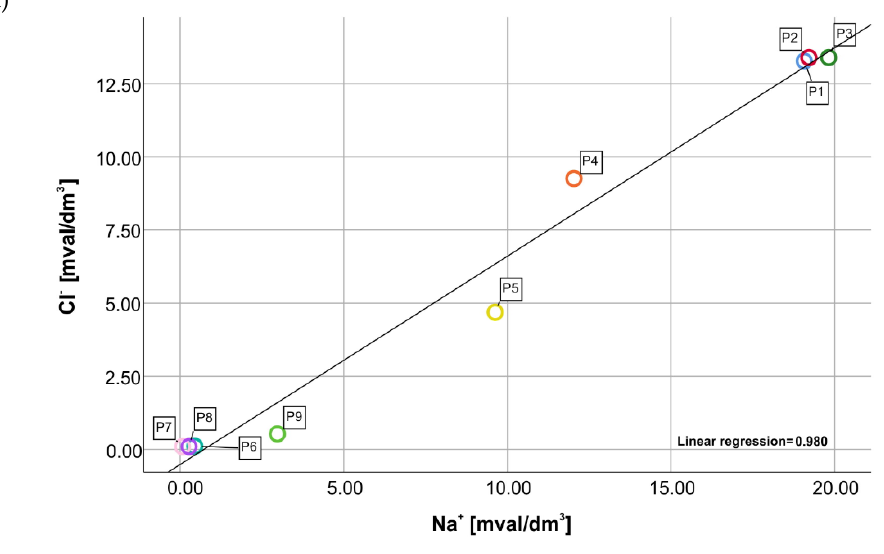
Table 4. The hydrochemical ratios values for individual sampling points ordered by location from North to South.